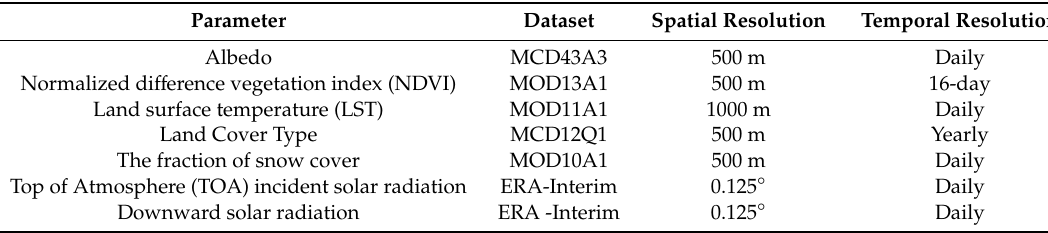
Table 1. The datasets used in this study.